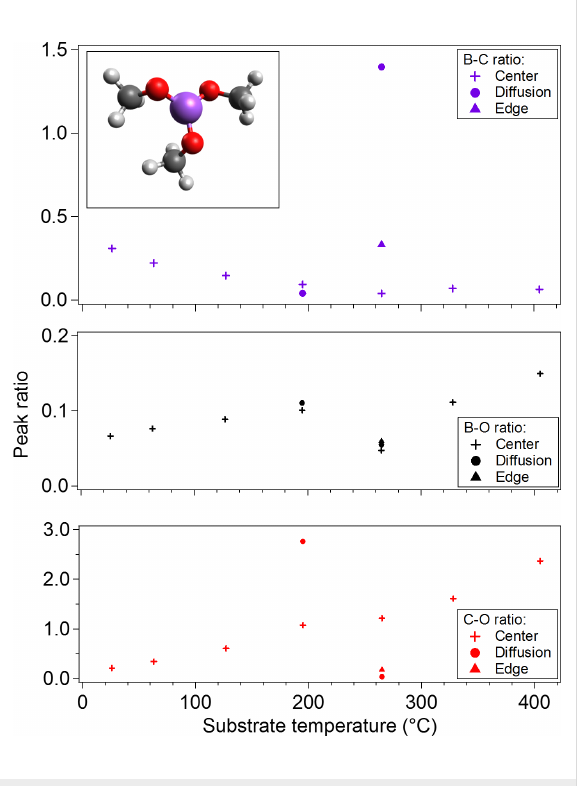
Figure 3: Elemental composition of material deposited by EBID using TMB precursor as a function of the substrate temperature. The compo- sition is presented as the boron-to-carbon, boron-to-oxygen and car- bon-to-oxygen K α X-ray peak intensity ratios with no corrections applied. The composition was determined by EDS in the region at the center of the electron beam used for deposition, in the region of the deposit where an abrupt interface was formed due to the diffusion limited growth regime, and in the region at the outer edge of the deposit (ca. 50 μ m from the diffusion region). These regions are labeled in Figure 4. Inset: TMB